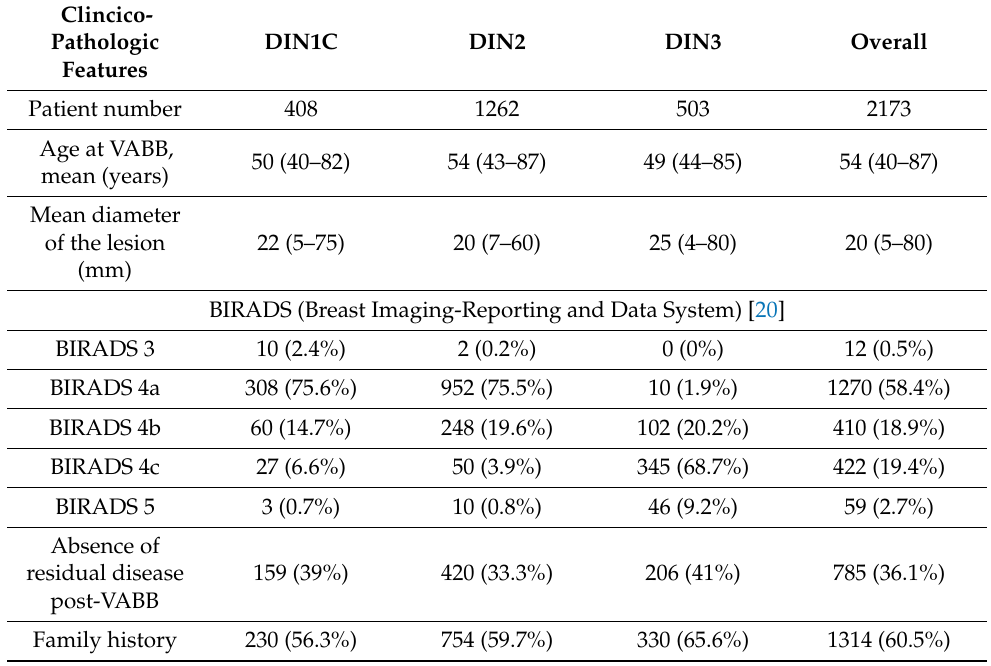
Table 2. Patient